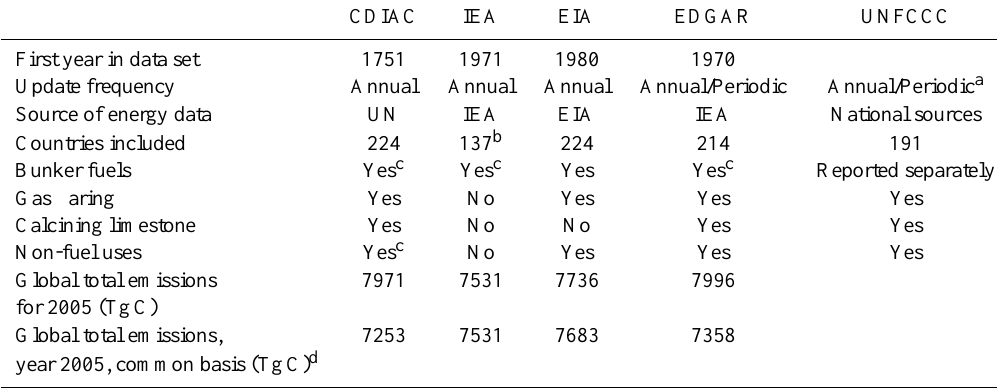
Table 1. Comparison of five global FFCO2 emissions